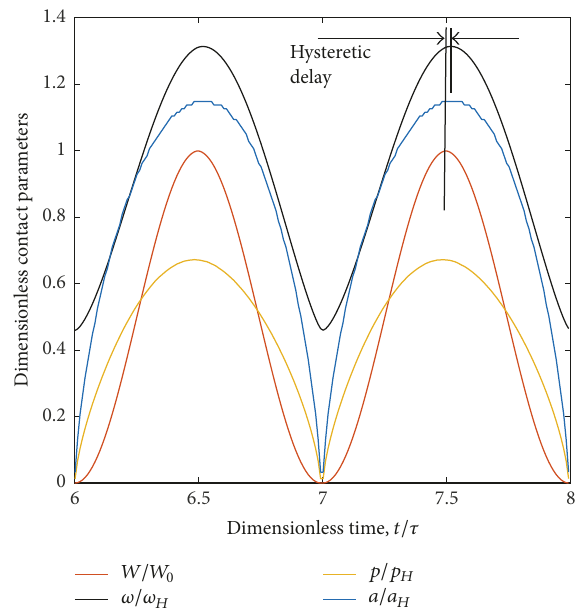
Figure 9: Contact stabilization, 7th and 8th loading cycles, 𝑓 = 0.1 Hz ⋅ s, simulation time 𝑡 = 8𝜏 (i.e., 8 loading